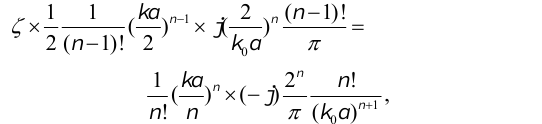
Bistatic normalized echo widths inclusive of transparency, and resonance conditions for both TE and TM polarizations are performed by Matlab simulation. Under resonance condition, Fig. 7-b, the minimum RCS has happened in both incident, and backscattering directions, and almost at φ =90 0 . Under transparency condition, Fig. 7-a, the maximum RCS has occurred dramatically in the incident direction,